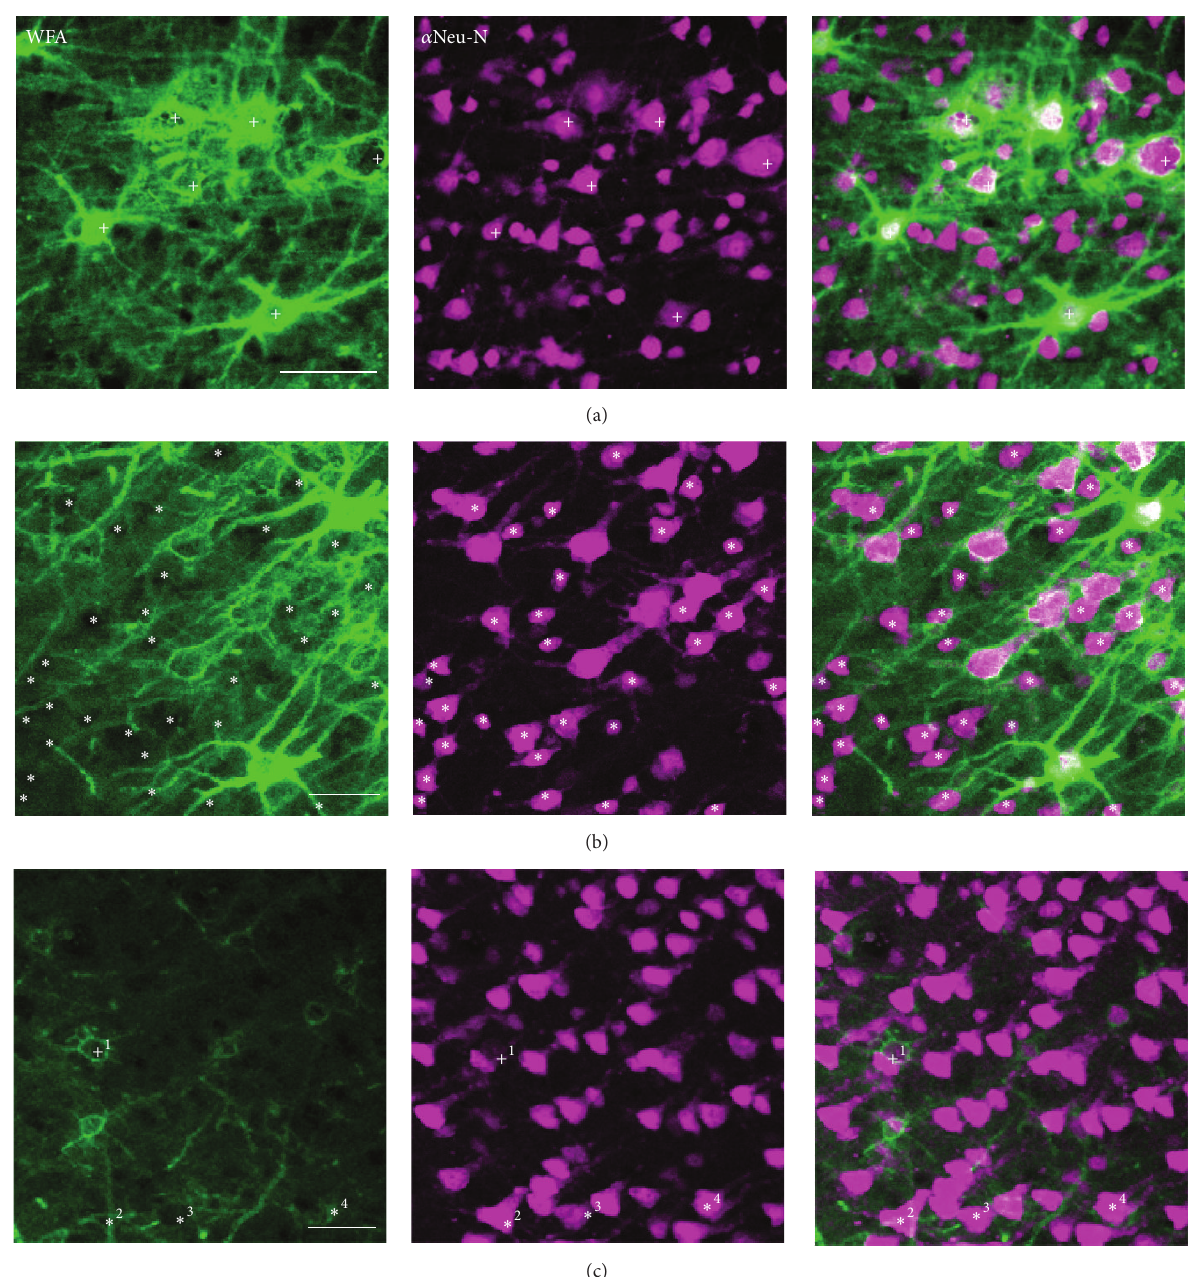
Figure 2: Perineuronal net identification. WFA, NeuN, and combined labeling in primary motor cortex. (a) shows labeling that we identified as PNN-positive, marked with +. (b) shows labeling that we identified as PNN-negative. Cells without PNNs are indicated with ∗ . (c) shows some examples of how we classified more ambiguous labeling. 1: a cell with strong WFA and weak NeuN staining, which we classified as WFA+ (+ symbol). 2: labeling which looks like it might surround a cell but does not clearly surround NeuN labeling ( ∗ symbol). 3: cells that produce absence of background labeling in the WFA channel but are not associated with clear WFA labeling. Even though the background is brighter than the “black” region, we do not identify these cells as WFA+, because they do not have a clear ring-like net ( ∗ symbol). 4: cell with partial somatic WFA staining, but because the ring around the cell is incomplete, we cannot unambiguously classify the cell as PNN-positive ( ∗ symbol). Scale bars are 50 𝜇